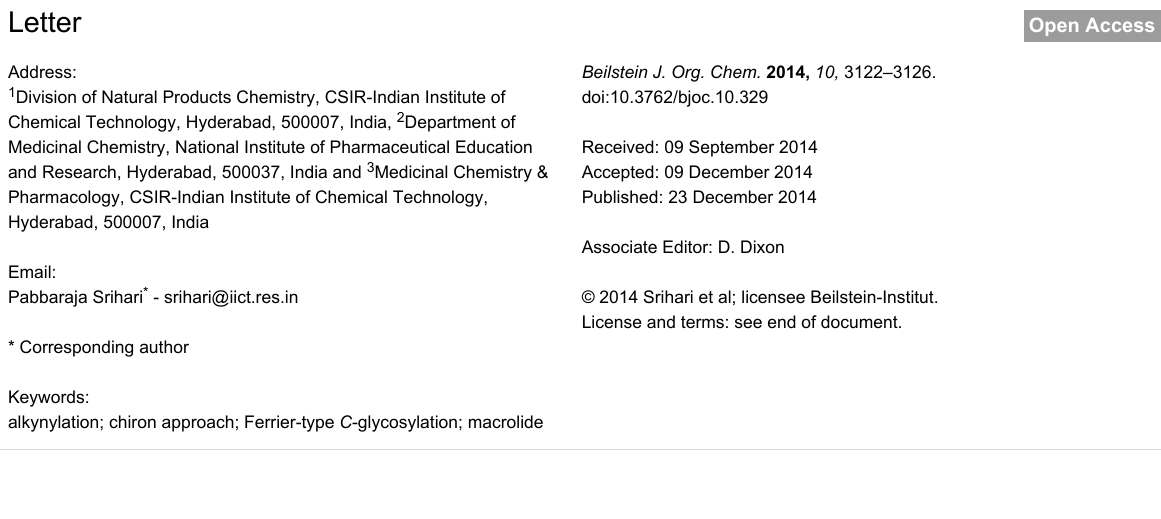
and both enantiomers of aspergillide C [21]. The chiron ap- proach has been a conventional strategy to achieve the total syn- thesis of complex, natural products with known